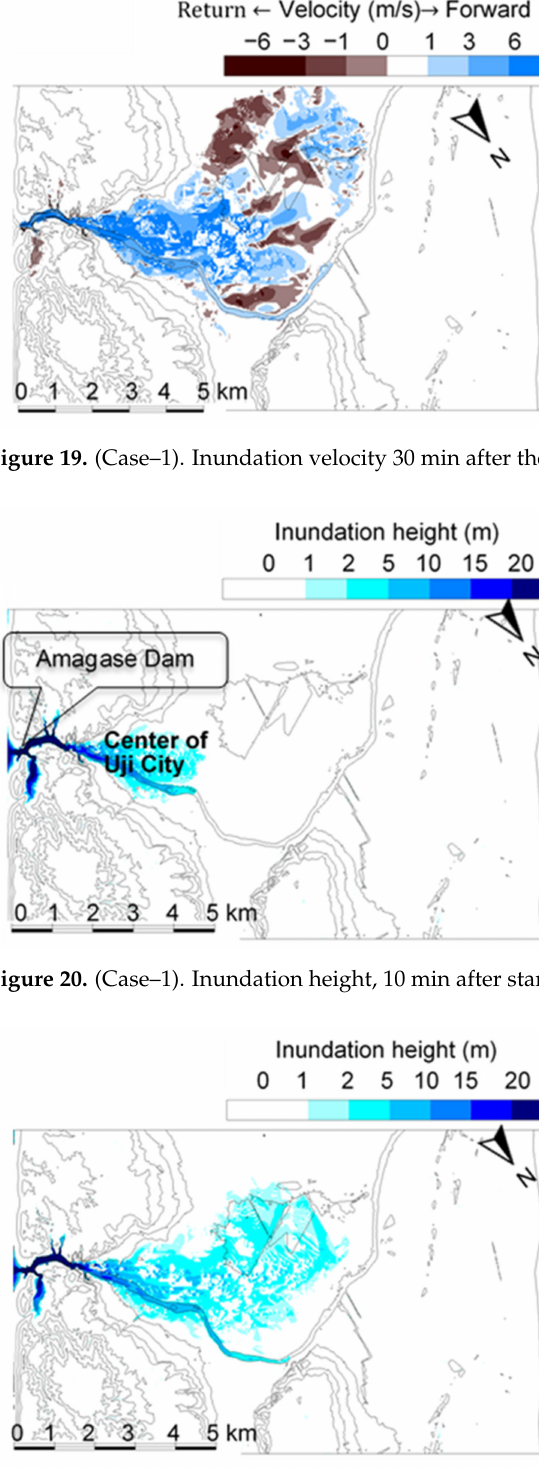
Figure 21. (Case–1). Inundation height, 20 min after start of the